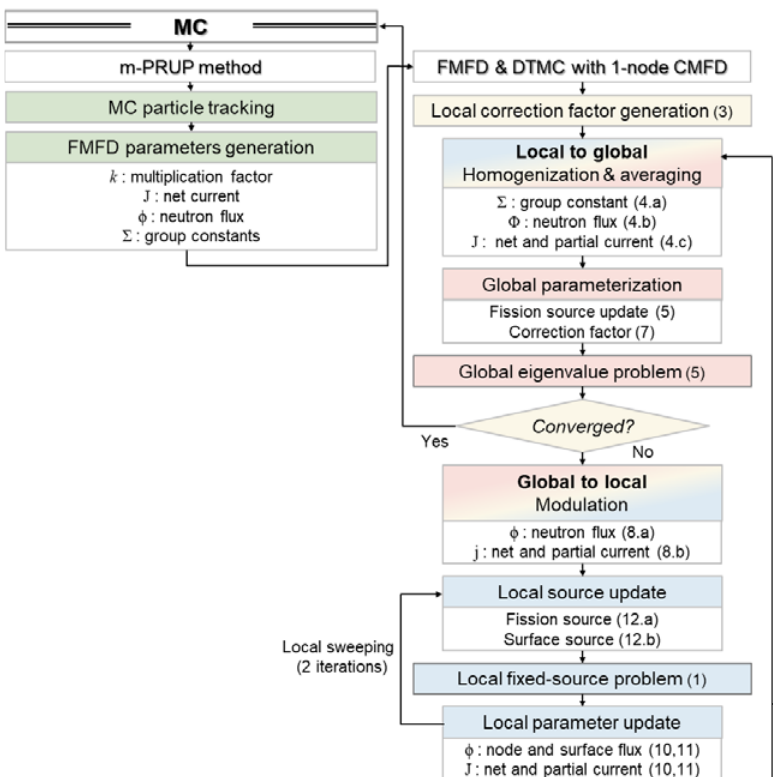
Figure 2. Flow chart of the FMFD with the 1-node CMFD method in MC simulation